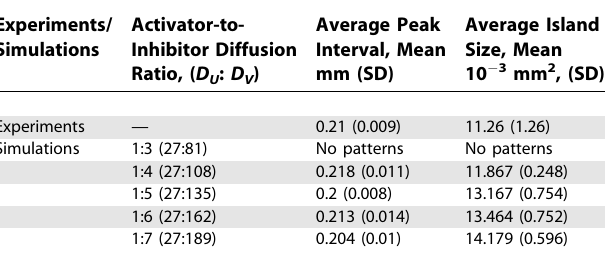
Table 1. Variation of Average Peak Interval and Average Island Size over a Range of Diffusion Ratios Experiments/